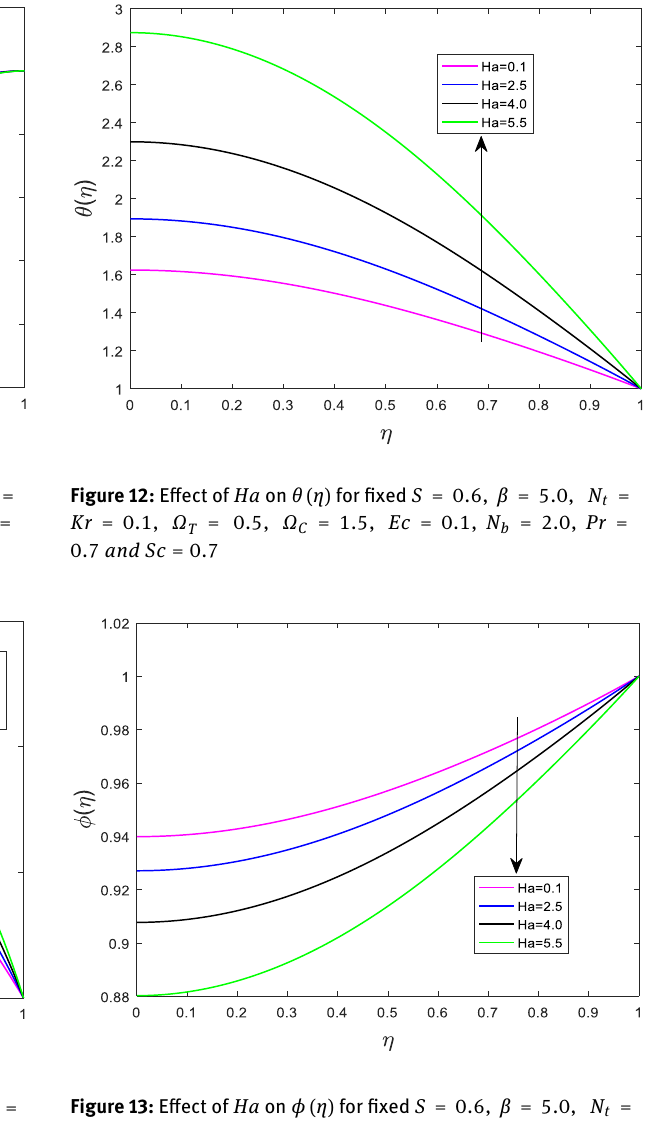
Figure 11: Effect of Ha on F (cid:48) ( η ) for fixed S = 0.6, β = 5.0, N t = Kr = 0.1, Ω T = 0.5, Ω C = 1.5, Ec = 0.1, N b = 2.0, Pr = 0.7 and Sc = 0.7